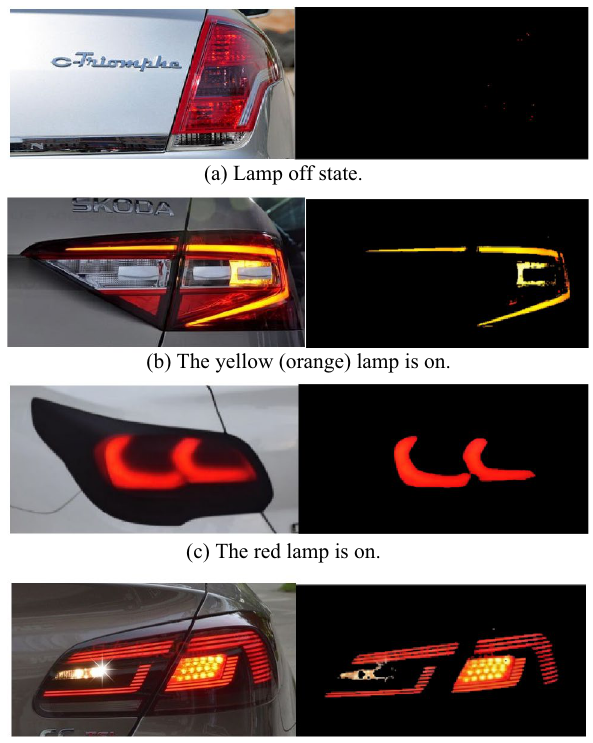
Fig. 7 Threshold segmentation results of this